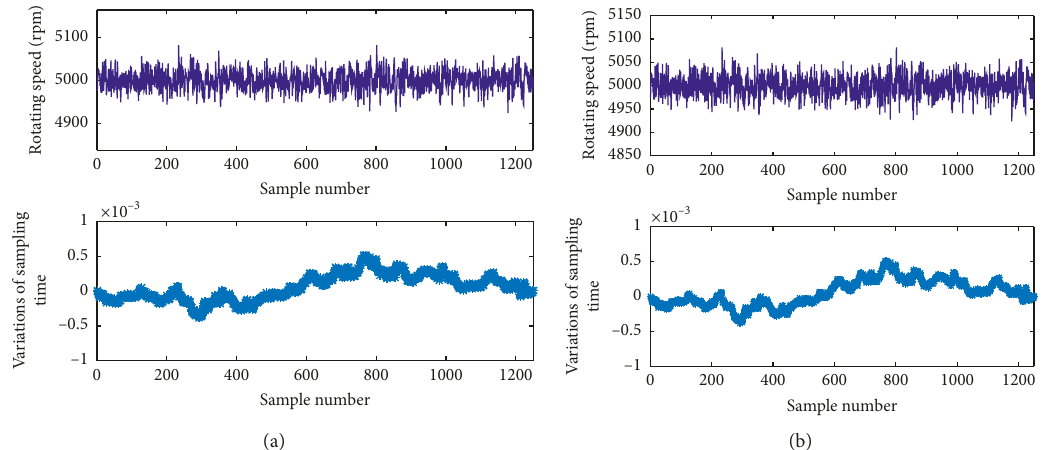
Figure 4: Stochastic speed fluctuation and variations of BTT sampling time: (a) URS � 3.16%; (b) URS � 6.33%.